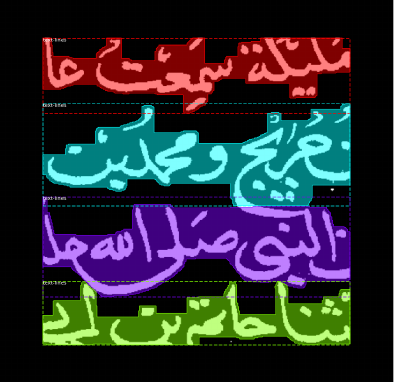
Figure 3. Example of text line fragments in a patch.